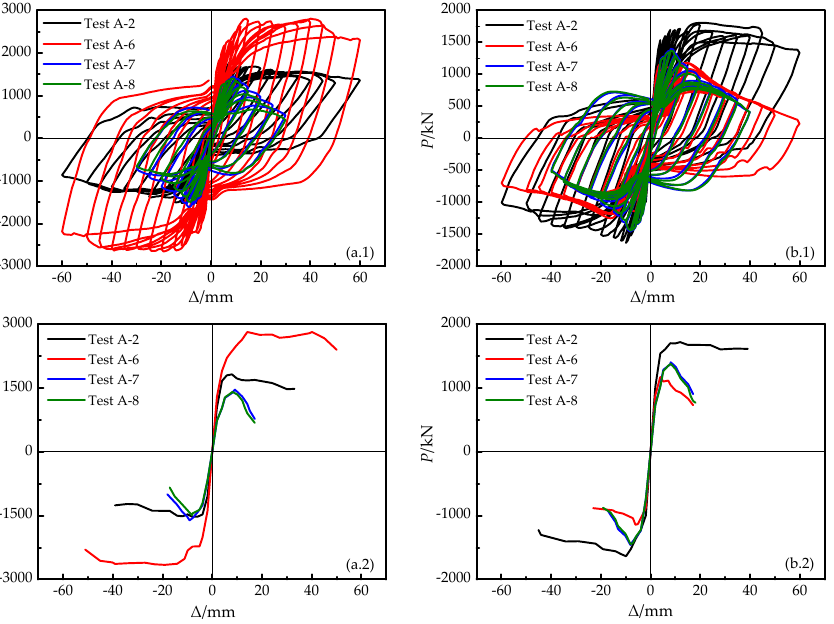
Figure 8. Hysteretic curves and skeleton curves of different lateral loading modes: ( a.1 , a.2 ) Node8; ( b.1 , b.2 ) Node18.